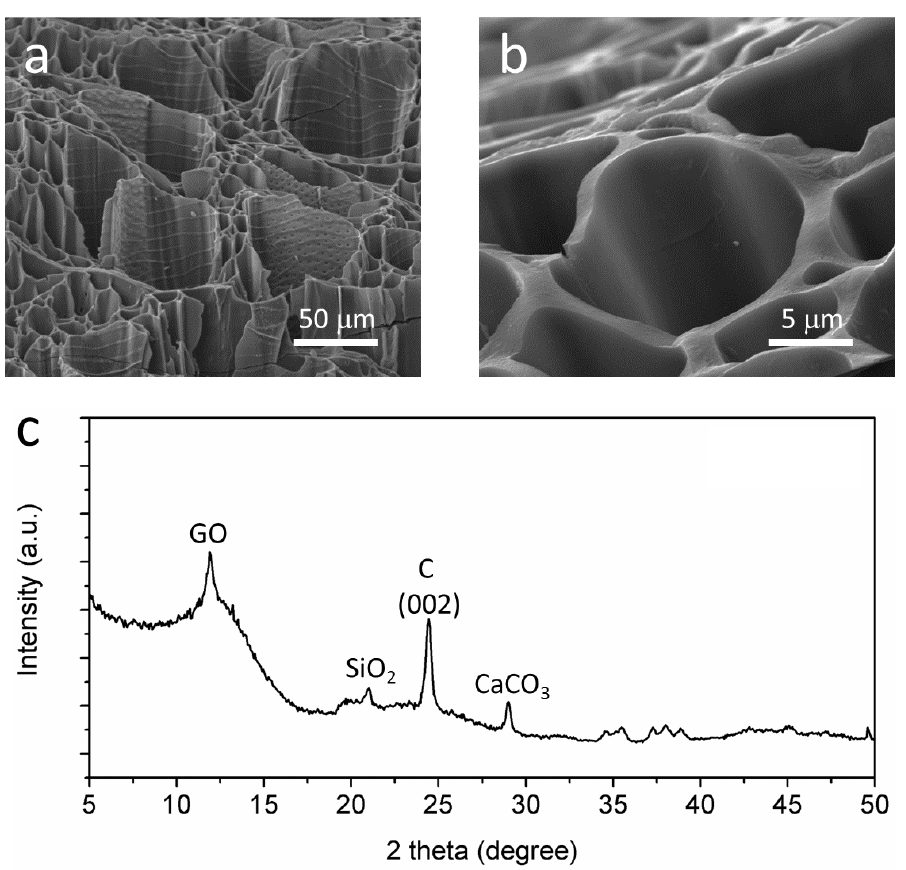
Figure 1. ( a , b ) SEM images of carbonized wood (CW) channels; ( c ) XRD of CW.